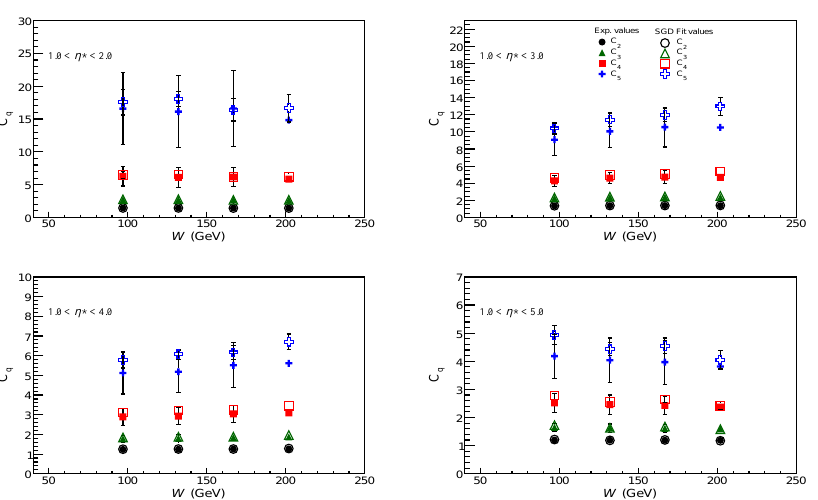
Figure 10. Normalized moments C q for q = 2, 3, 4, 5 for the SGD fits and comparison with the values calculated from the data [33] in different η ∗ ranges.